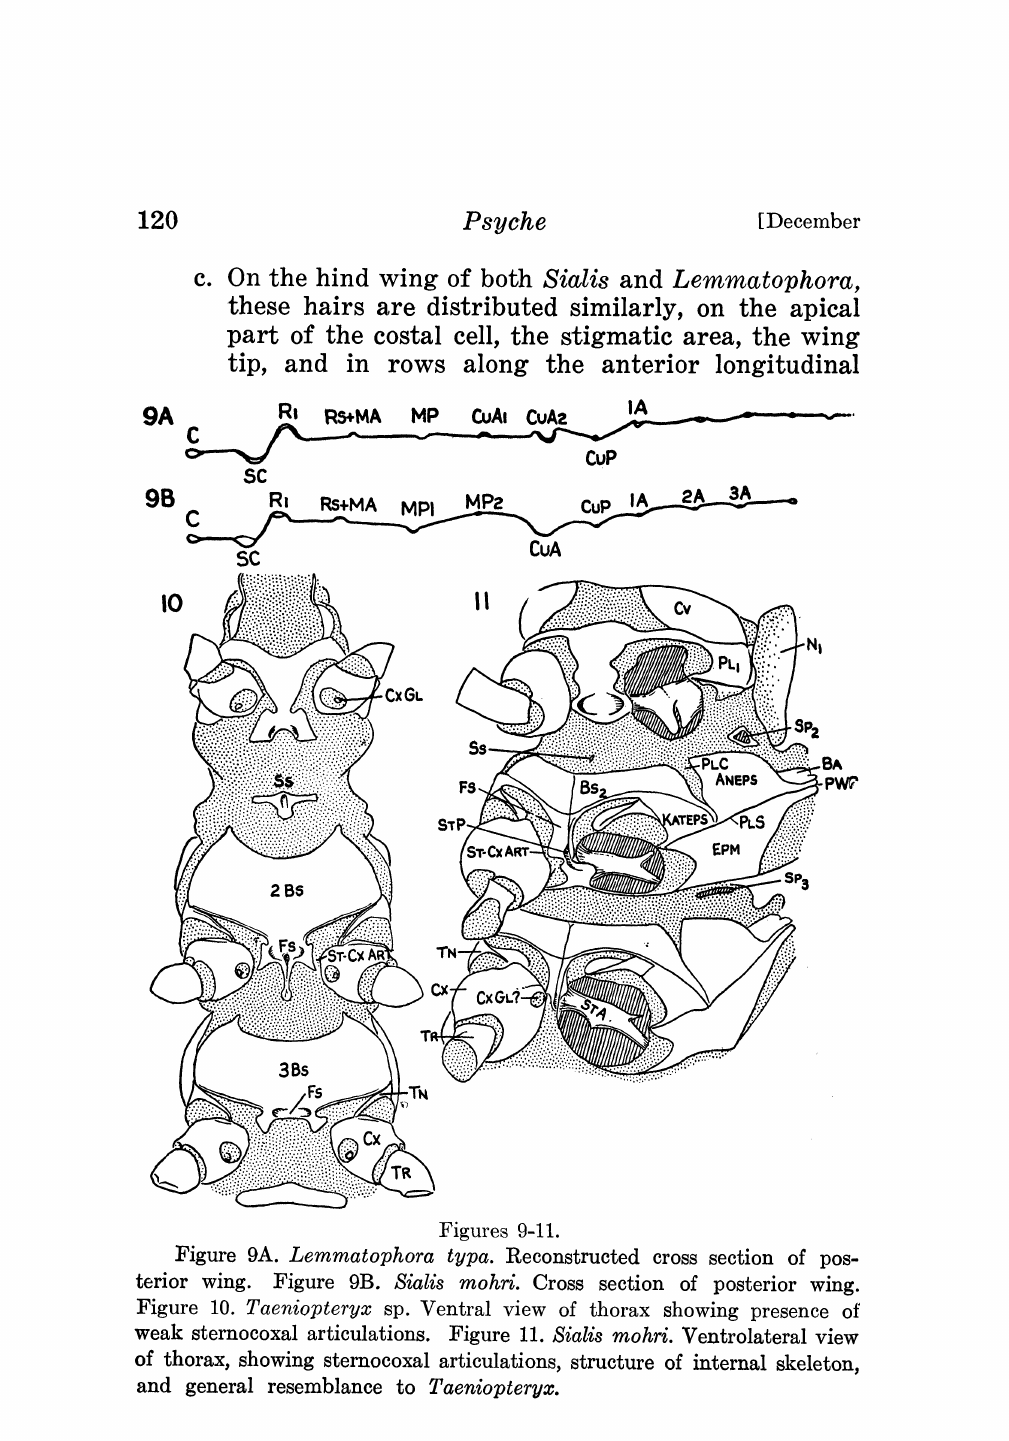
Figures 9-11. Figure 9A. Lemmatophora typa. Reconstructed cross section of pos- terior wing. Figure 9B. Sialis mohri. Cross section of posterior wing. Figure 10. Taeniopteryx sp. Ventral view of thorax showing presence of weak sternocoxal articulations. Figure 11. Sialis mohri. Ventrolateral view of thorax, showing sternocoxal articulations, structure of internal skeleton, and general resemblance to